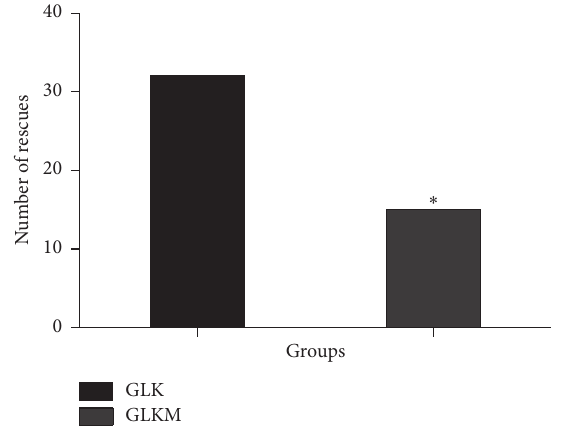
Figure 3: Total number of rescues in female dogs submitted to unilateral radical mastectomy, continuous infusion of lidocaine and ketamine (GLK), and continuous infusion of lidocaine, ket- amine, and maropitant (GLKM) during the six hours postoperative evaluation, ∗ P < 0.05.